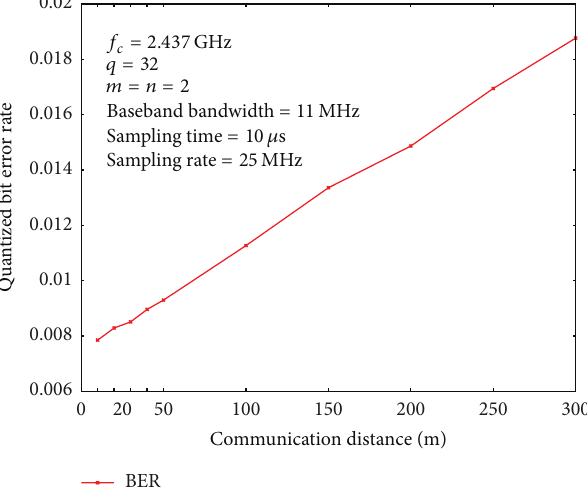
Figure 7: Bit error rates under different communication